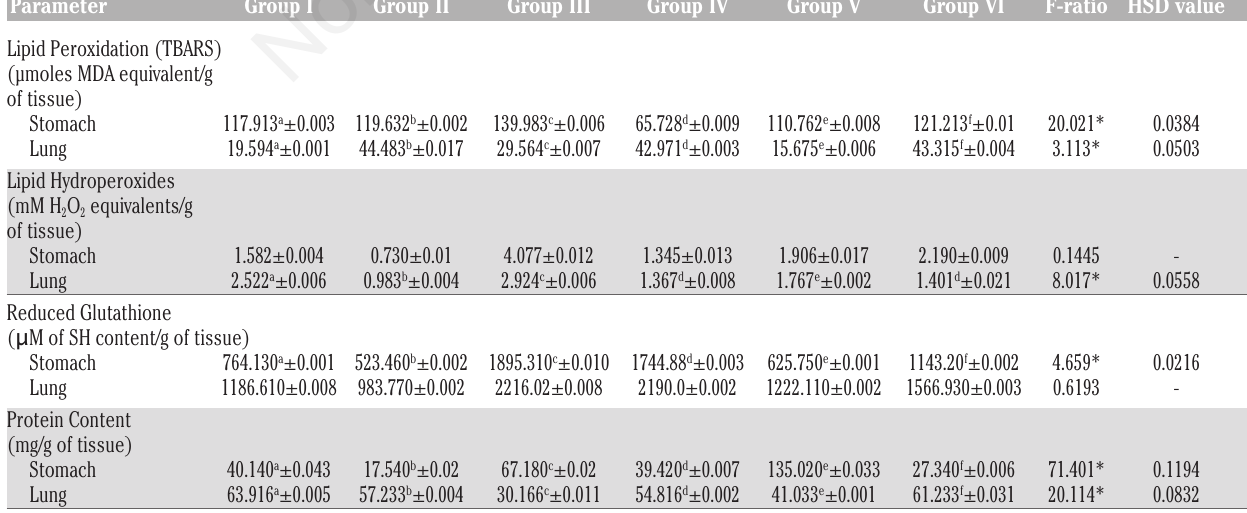
Table 5. Modulation of DMBA induced impairment of oxidative stress parameters by betulinic acid among different treatment groups of female Sprague Dawley rats. Parameter